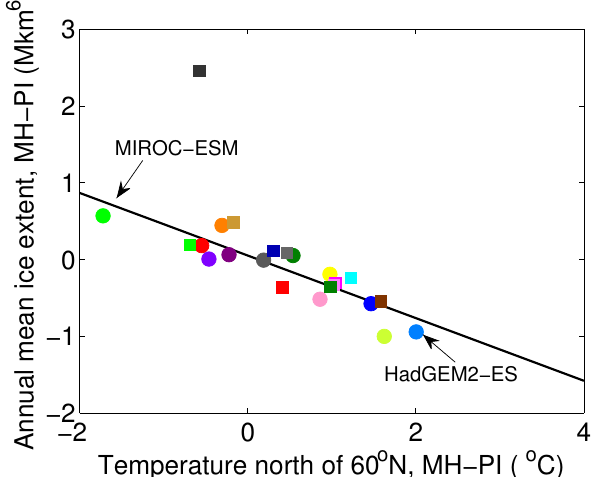
Fig. 6. Change in summer (JJA) surface temperature ( ◦ C) north of 60 ◦ N and annual mean sea-ice extent (M km 2 ) in the North- ern Hemisphere, between MH and PI, for PMIP3 (circles) and PMIP2 (squares). Model legends are the same as in Fig. 3. Note that MIROC-ESM and HadGEM2-ES are located on opposite sides of the sensitivity range.